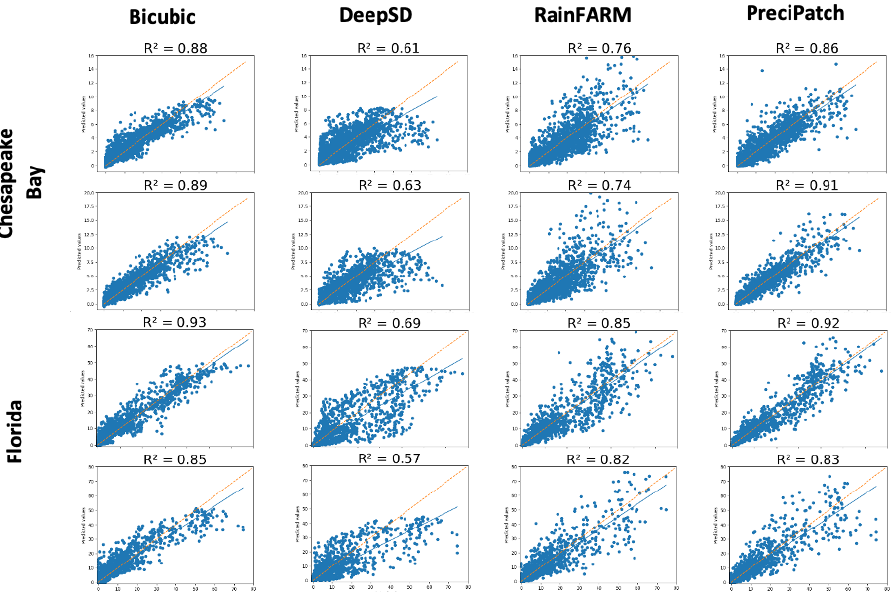
Figure 6. The Chesapeake Bay and Florida—R². The x-axis refers to the ground truth, and the y-axis is the prediction. The 45 degrees line in each graph is the perfect match reference line between the prediction and the ground truth, showing as the dashed line, the solid line is the trending line. 1st row: hourly precipitation at Chesapeake Bay area on 2018/7/21 (23:30:00 UTC), 2nd row: hourly precipitation at Chesapeake Bay area on 2018/7/21 (16:30:00 UTC), 3rd row: hourly precipitation at Florida area on 2018/12/14 (05:30:00 UTC), 4th row: hourly precipitation at Florida area on 2018/12/14 (18:30:00 UTC).